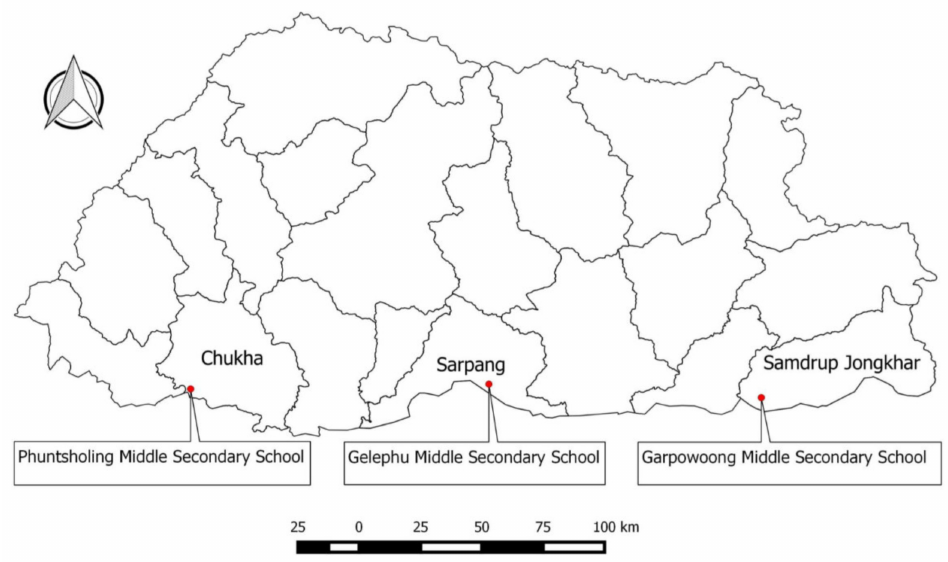
Figure 1. Map of Bhutan showing the location of three schools in which the study was conducted (Bhutan is located between China in the north and India in the south, east, and west). The names and borders of the districts are indicated as well as the location of the schools surveyed (red dots). The map was prepared using Quantum GIS, QGIS Development Team (2019), QGIS Geographic Information System, Open-Source Geospatial Foundation Project (http://qgis.osgeo.org) and was not taken from another